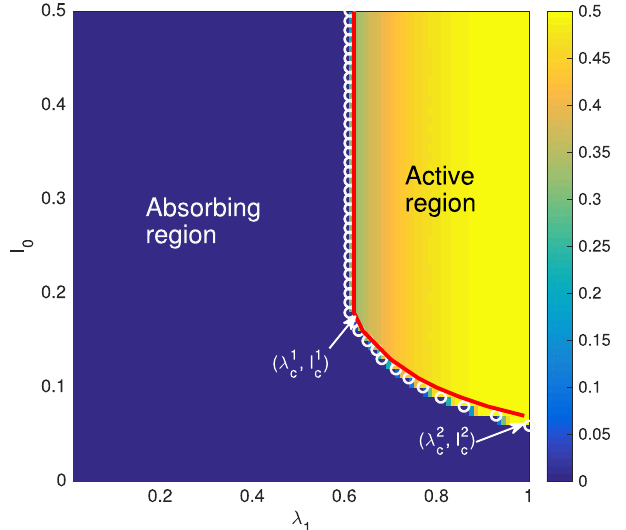
Figure 2. Color-coded of the final adoption size ρ from simulations versus the initial seeds I 0 and information (cid:31)(cid:30) transmission probability λ 1 with θ = (4, 3, 1) . The critical points λ c separate the ( λ 1 , I 0 ) into absorbing and active regions. The symbols and lines are the numerical and theoretical predictions of λ c ,